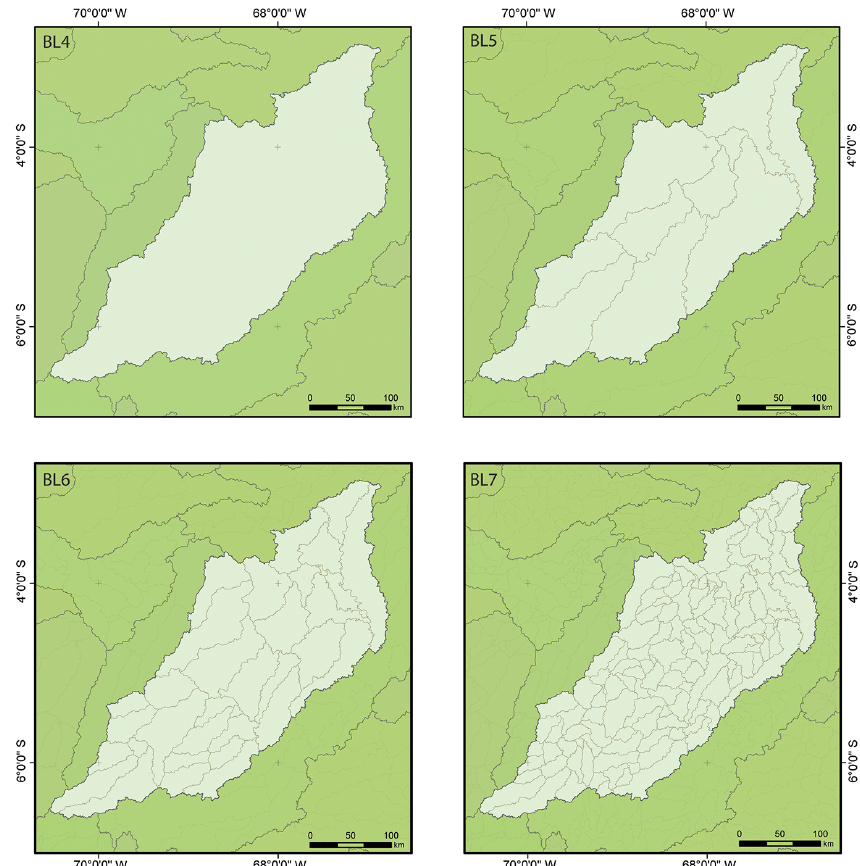
Figure 2. Cartographic representation of Amazon Basin classification levels 4, 5, 6 and